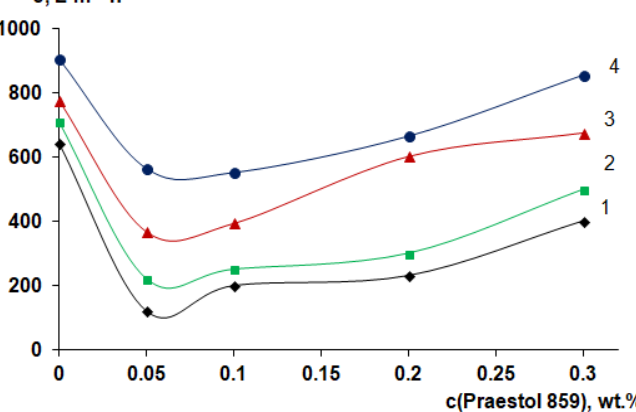
Figure 12. Dependence of pure water flux of PSF-based membranes on Praestol 859 concentration in the coagulation bath and coagulation bath temperature: 1 — 25 °C; 2 — 40 °C; 3 — 60 °C; 4 — 70 °C. A flux of 0.5 wt.% HSA solution at pH = 7.0 was found to slightly decrease when Praestol 859 concentration increases in the coagulation bath (Figure